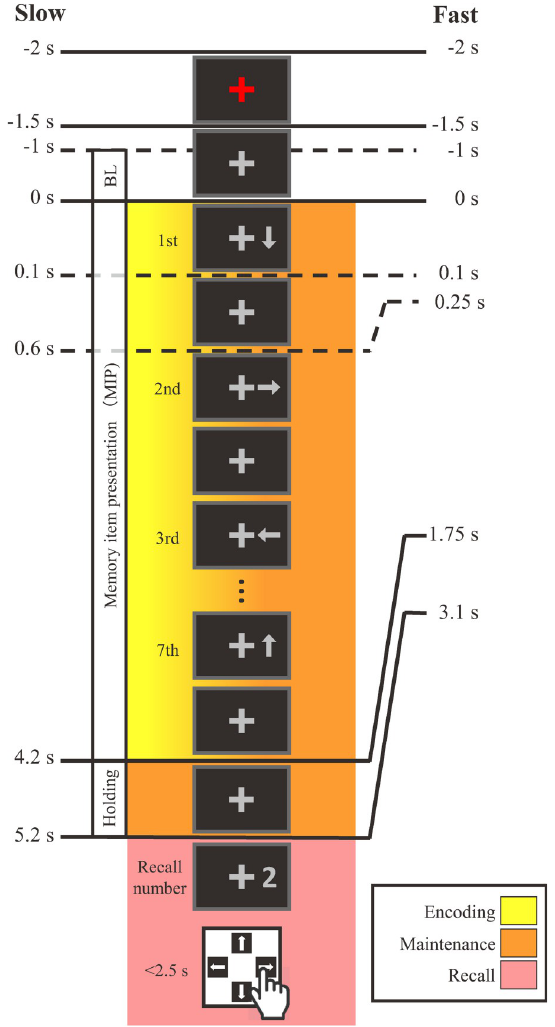
Fig 1. Schematic diagram of a trial of the slow (left) and fast (right) sequential memory tasks. In both tasks, seven arrows were presented sequentially as memory items. The inter-stimulus intervals between the presentation onset of each arrow in the slow and fast conditions were 0.6 s and 0.25 s, respectively. Upon presentation of a recall number cue, each participant answered the arrow direction corresponding to the recall number by pressing a button on a keypad. The color gradient indicates that both encoding and maintenance processing were concurrent during the memory item presentation period. BL: